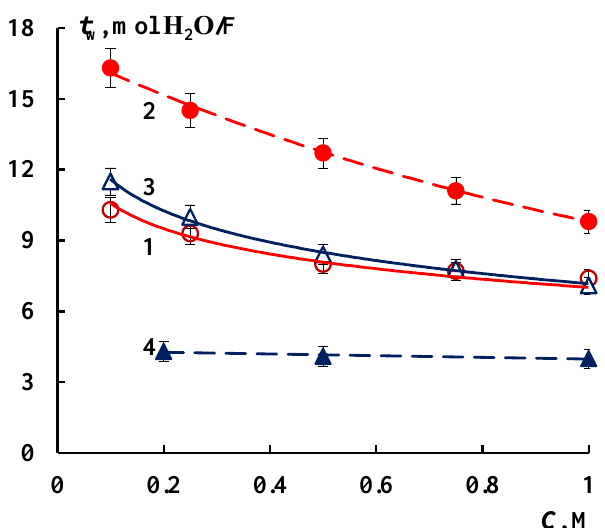
Figure 3. Concentration dependences of membrane conductivity in NaCl solutions: 1 — Nafion, 2 — Nafion/SiO 2 , 3 — MF-4SK, 4 — MF-4SK/SiO 2 , 5 — MF-4SK/HZP, 6 — NaCl solution.